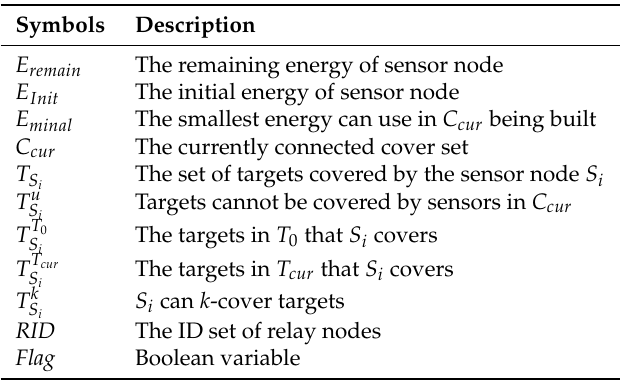
Table 1. Symbols and